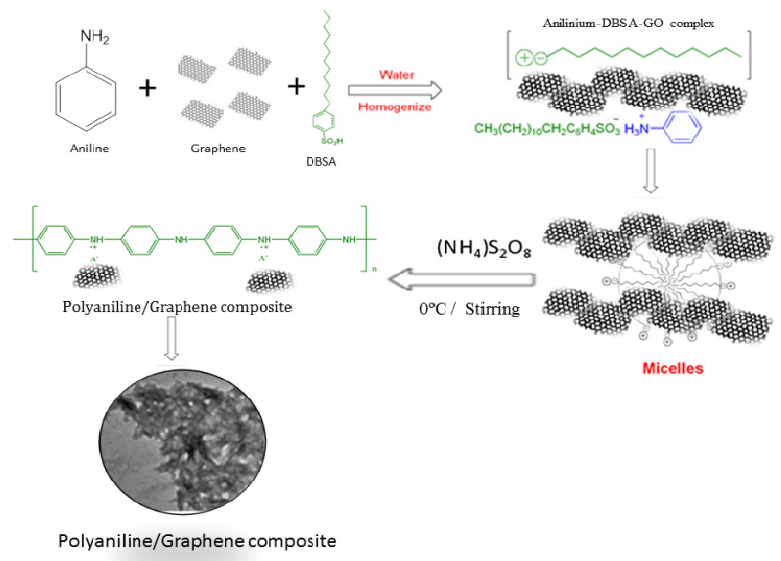
Figure 4. Fabrication of a polymer-based (polyaniline) graphene nanocomposite [61].